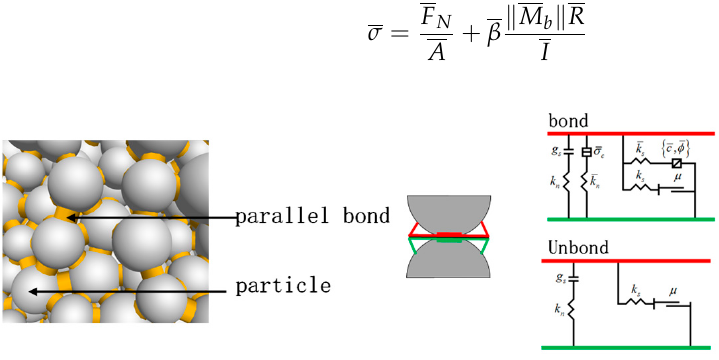
Figure 1. Parallel bonding model